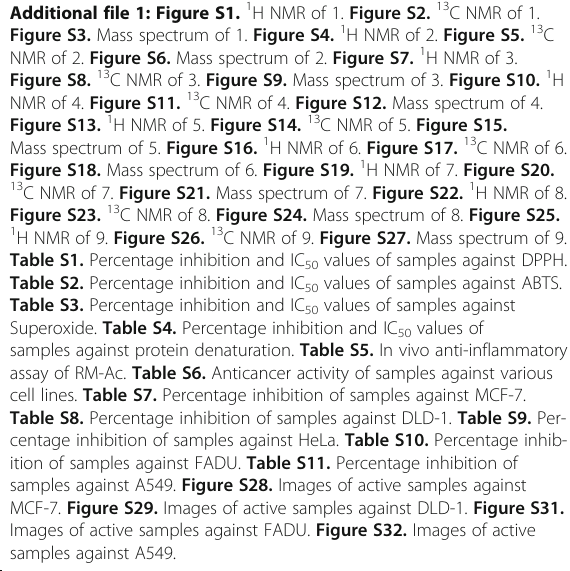
Table S8. Percentage inhibition of samples against DLD-1. Table S9. Per- centage inhibition of samples against HeLa. Table S10. Percentage inhib-